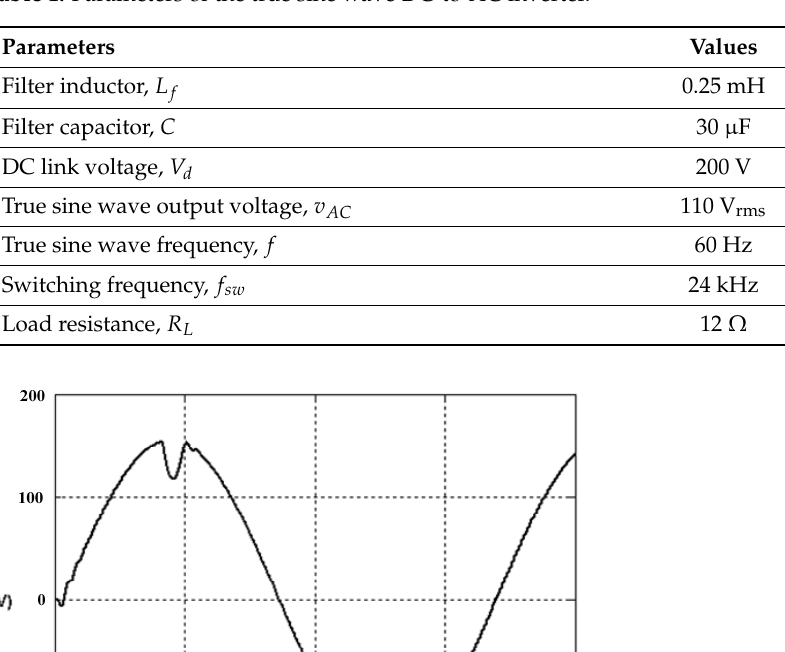
Table 1. Parameters of the true sine wave DC-to-AC inverter.